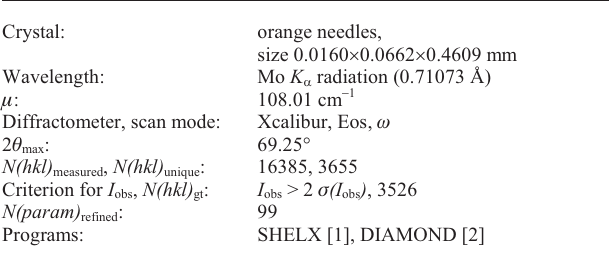
Table 1. Data collection and